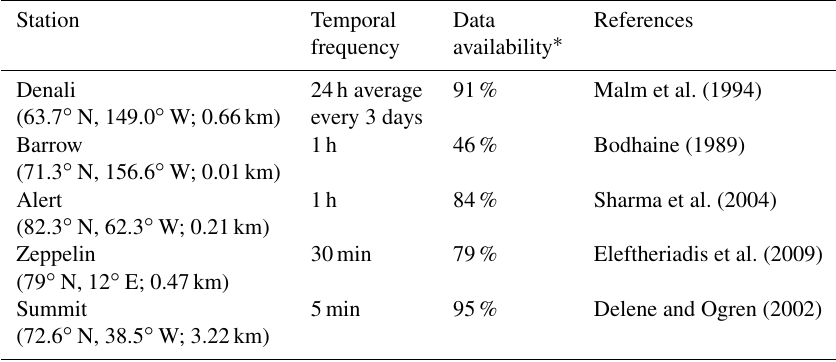
Table 1. Measurements of BC in surface air in the